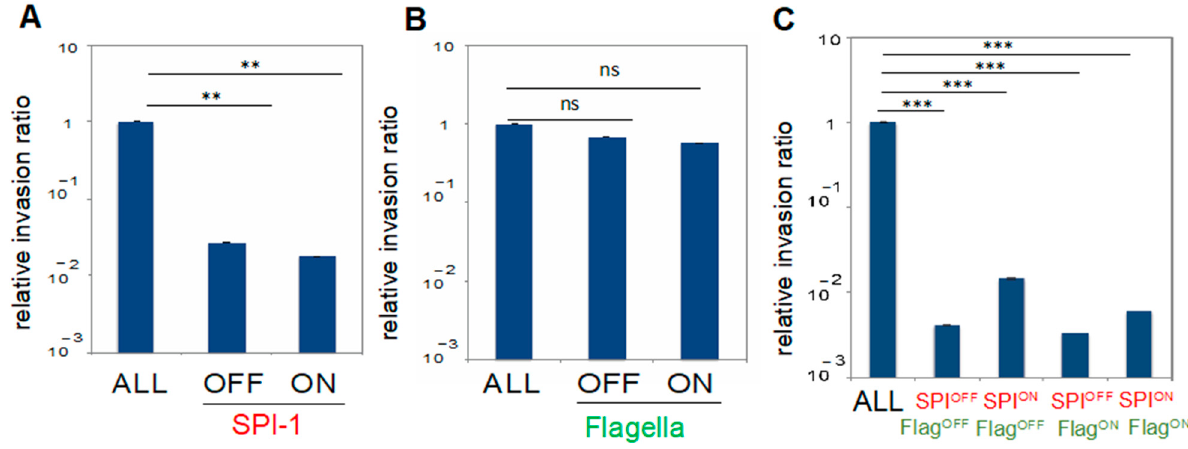
Figure 2. Invasion of epithelial cells by subpopulations expressing invasion and motility determinants (strain SV8533, sipB :: gfp and fliC :: mCherry ). ( A ) Invasion rates of sorted SPI-1 OFF and SPI-1 ON subpopulations. Assays were performed using aliquots from the whole bacterial population after passage through the cell sorter (“ALL”) and from SPI-1 ON and SPI-1 OFF subpopulations. ( B ) Invasion rates of sorted Flag OFF and Flag ON subpopulations. Culture aliquots used in the assays were as above. ( C ) Invasion rates of sorted SPI-1 OFF Flag OFF , SPI-1 OFF Flag ON , SPI-1 OFF Flag ON , and SPI-1 ON Flag ON subpopulations. An aliquot from the whole bacterial population after passage through the cell sorter (“ALL”) was included in the invasion assays. In all panels, averages and standard deviations from >3 independent experiments are shown. Statistical indications: ns, not significantly different; *** significantly different, p < 0.001; ** significantly different, p < 0.01.